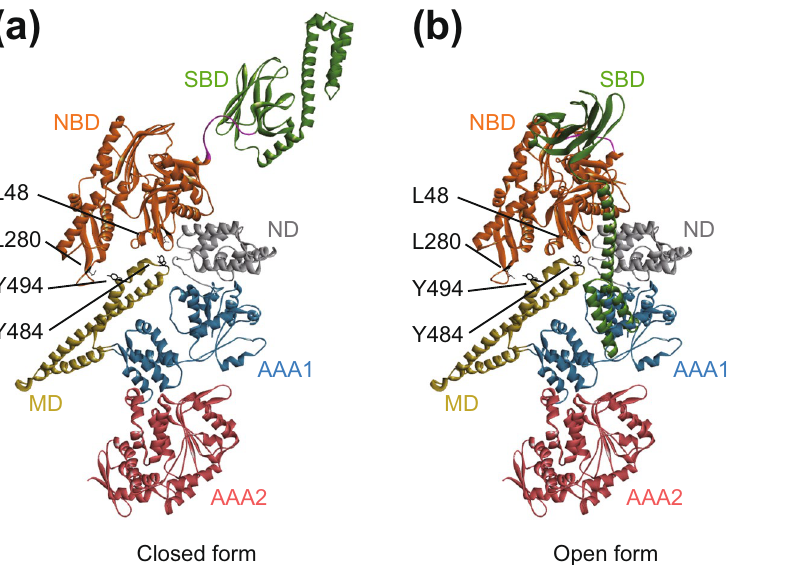
Figure 6. Models for the docked structure of T DnaK and T ClpB. Structural models of the closed ( a ) and the open ( b ) form of T DnaK were arrayed on the T ClpB structure as seen in the binding model proposed by NMR study 41